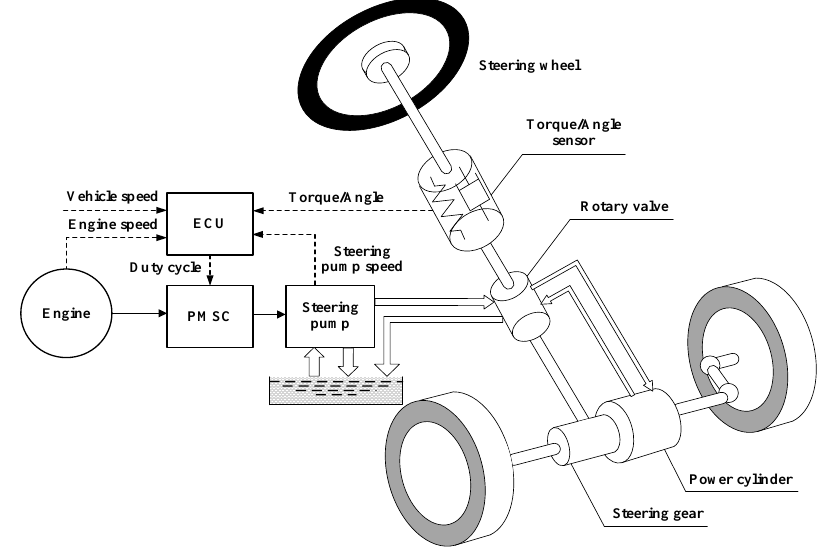
Figure 1. Composition diagram of P-ECHPS.